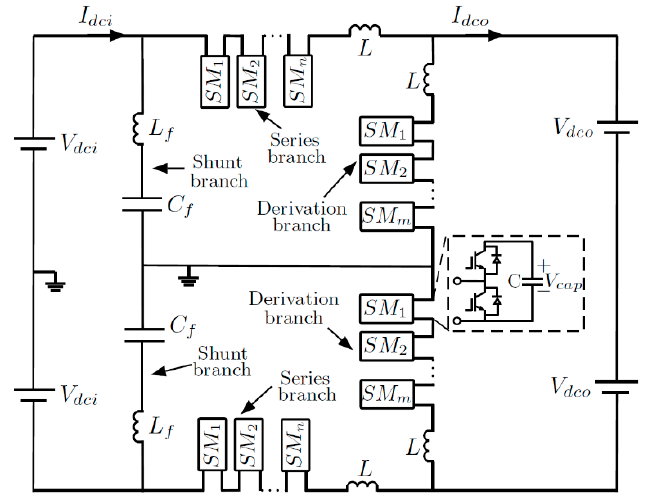
Figure 1. Structure of the double- Π converter topology.